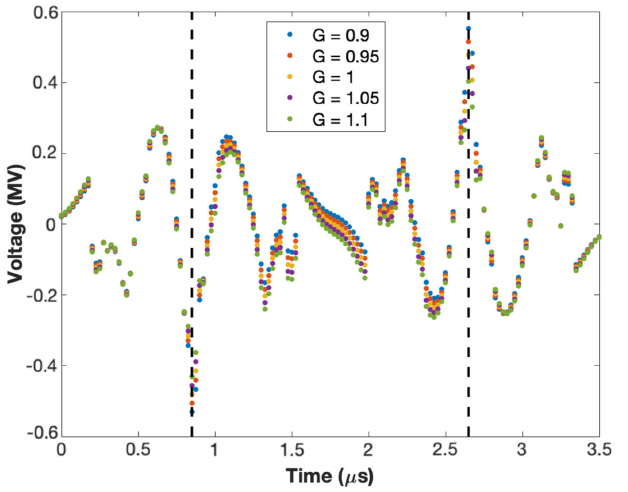
FIG. 11. Uncompensated beam loading with nonideal feedfor- ward gain (feedback on). Vertical markers indicate the extent of the batch.